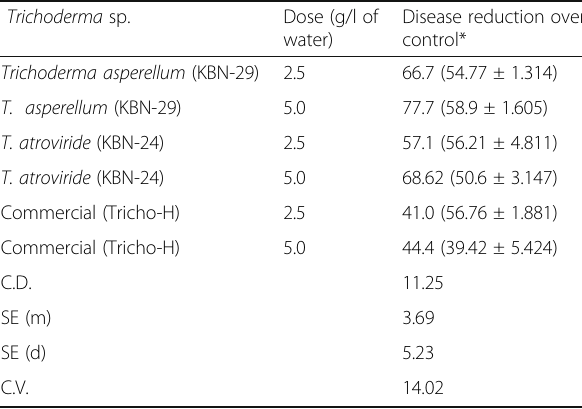
Table 4 In vivo bioefficacy of Trichoderma spp. against dieback disease Trichoderma sp.